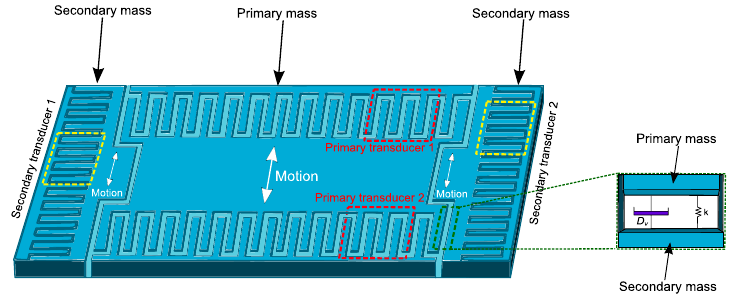
Figure 10. Electrostatic kinetic harvester.